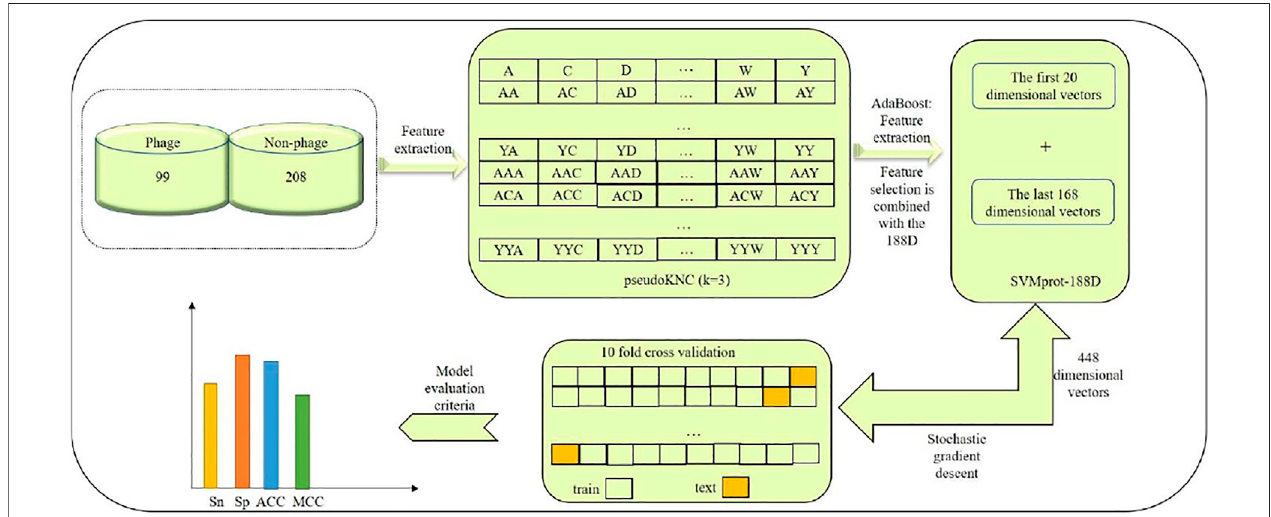
FIGURE 1 | Establishing model Pseudo-188D